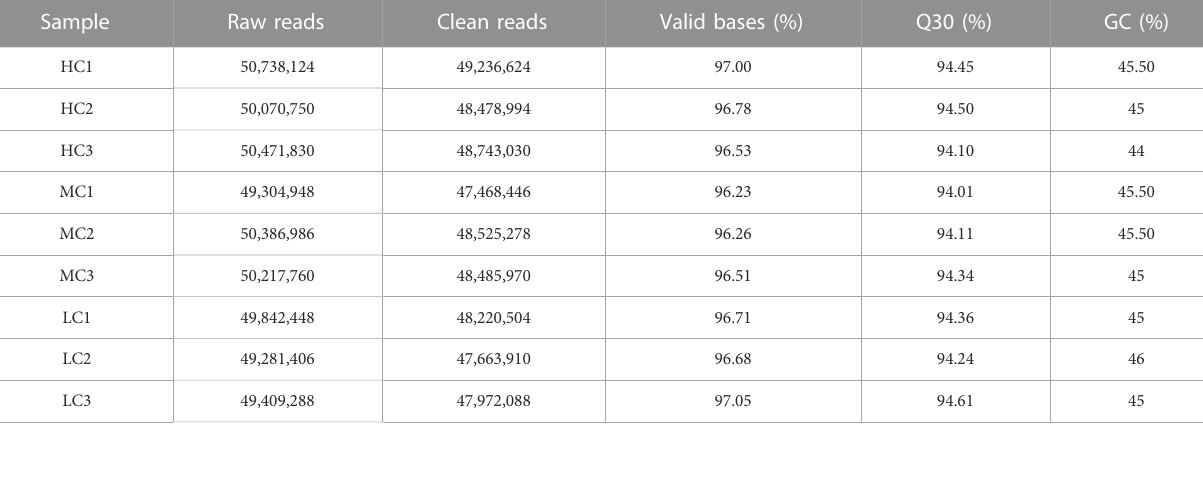
TABLE 2 Repeat type frequency of SSRs in the tested P. monodon transcriptome.